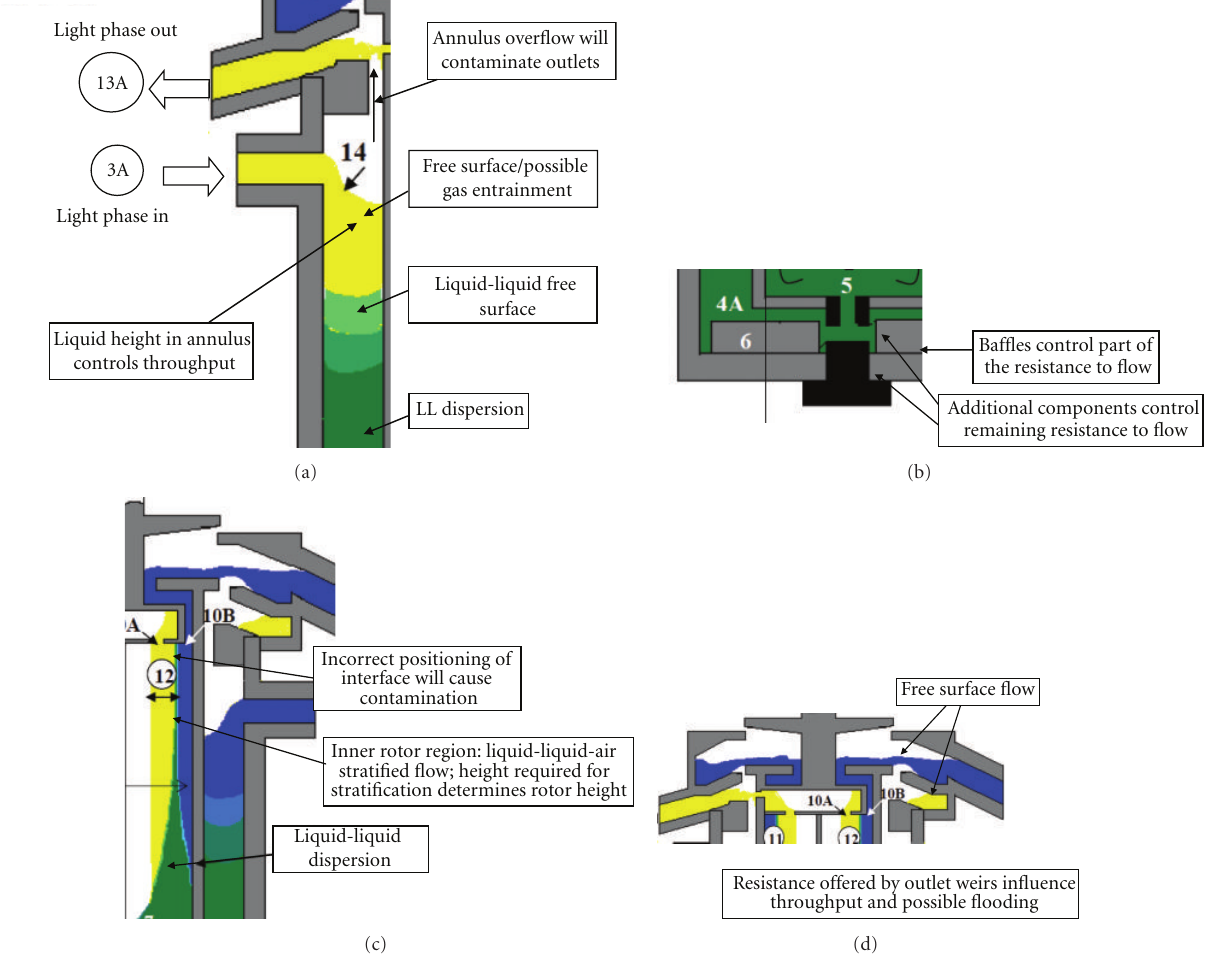
Figure 4: (a) Schematic representation of the inlet and outlet sections of ACE, (b) schematic representation of the bottom vanes and resistance, (c) dispersion band and sections tapping light and heavy phases in the separator region, (d) Heavy-phase weir and free surface flow at the top at the point of